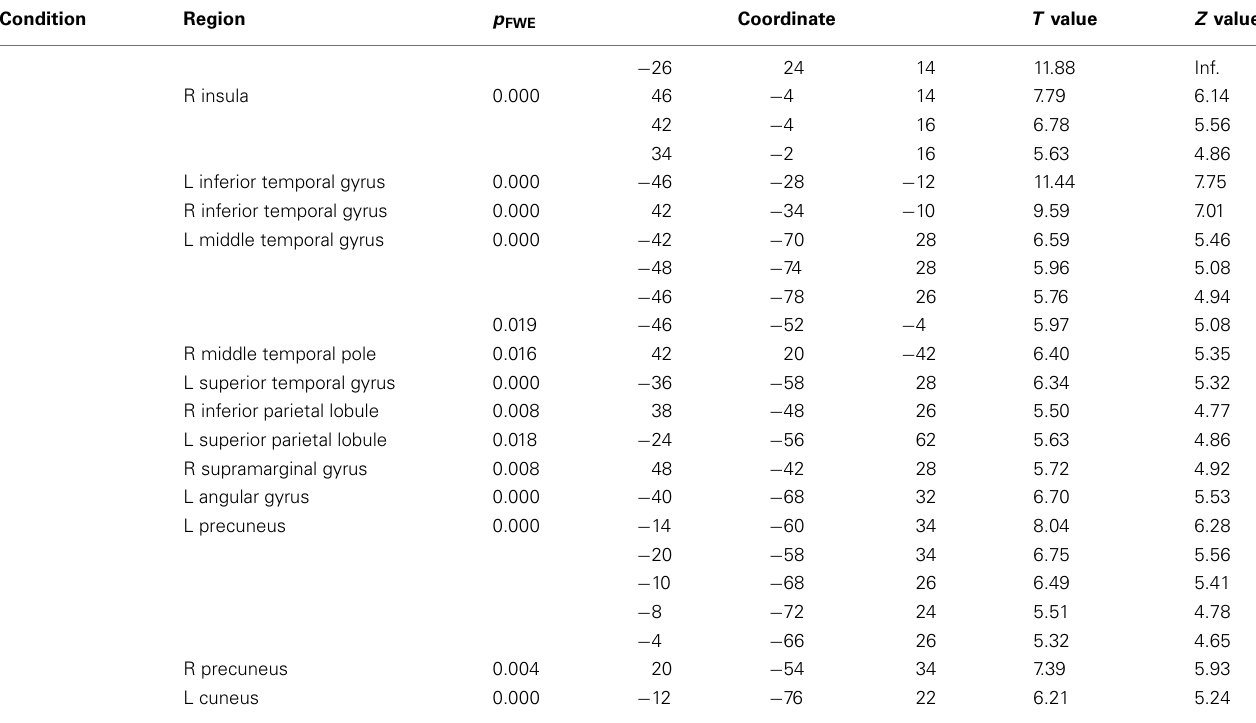
Overall, increased activation in the frontal operculum is interest- ing as patients reveal slower reaction times compared to controls. This may indicate that patients find the task more challenging than controls (as suggested by the percent correct scores),